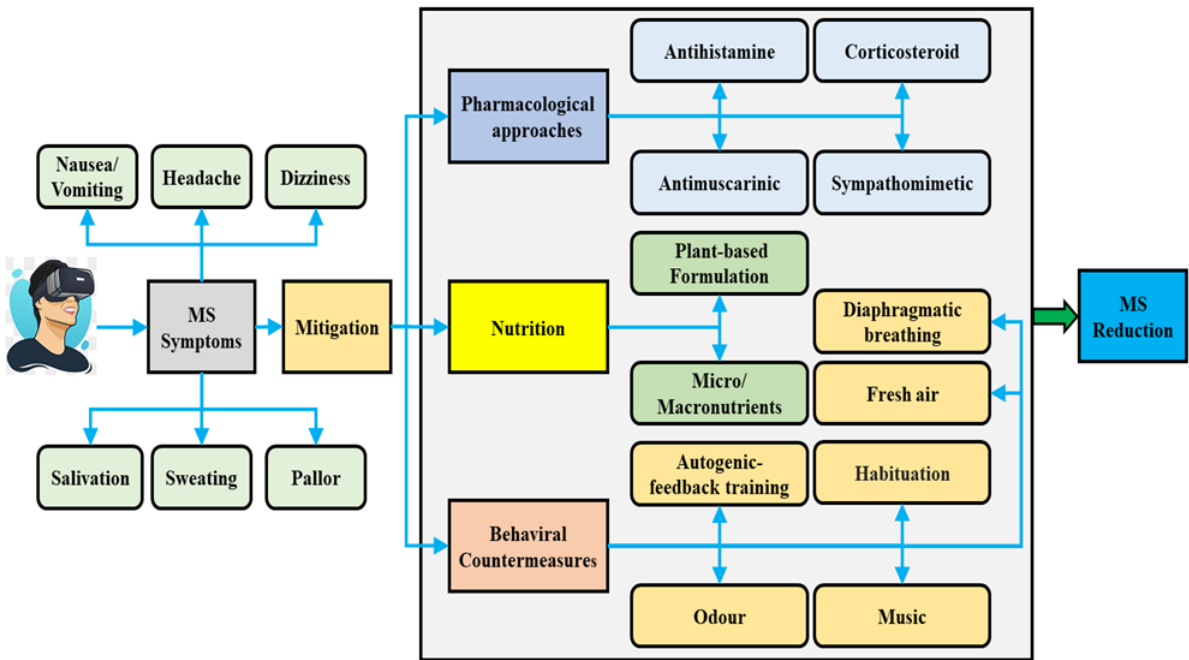
Figure 4. Motion Sickness (MS) can lead to similar symptoms in both real and virtual environments. Multidisciplinary interventions used for MS include pharmacological approaches, nutritional inter- ventions, and behavioral countermeasures such as favorite music, autogenic-feedback training, fresh air, odor, diaphragmatic breathing, and habituation.